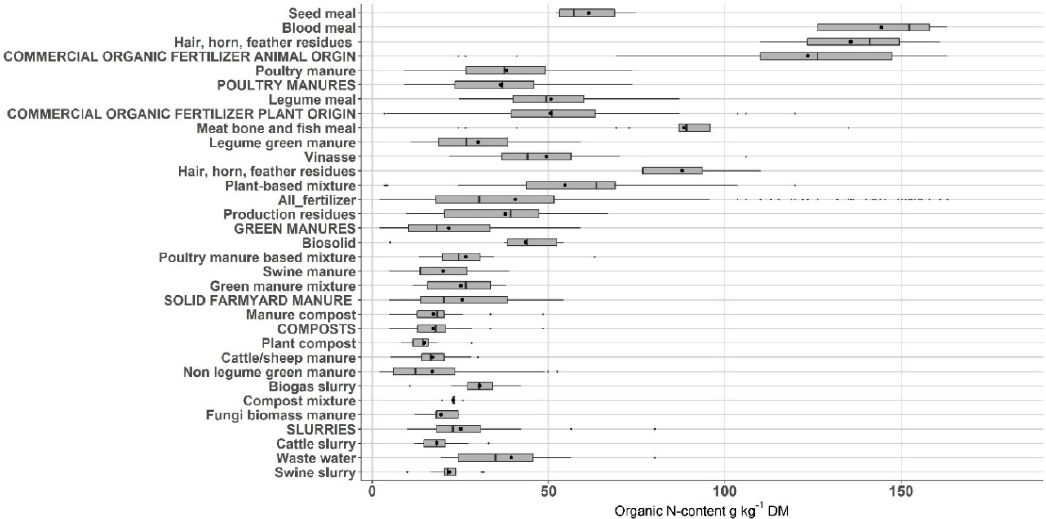
Figure 1. Boxplot of organic N content in the fertilizer main groups (capital letters) and subgroups. The circles are the means and the stripes are the medians of the observations.